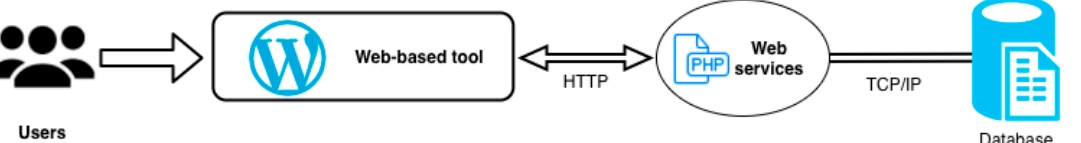
Figure 2. Schematic representation of the creation of the irrigation tool available on AgroClimate